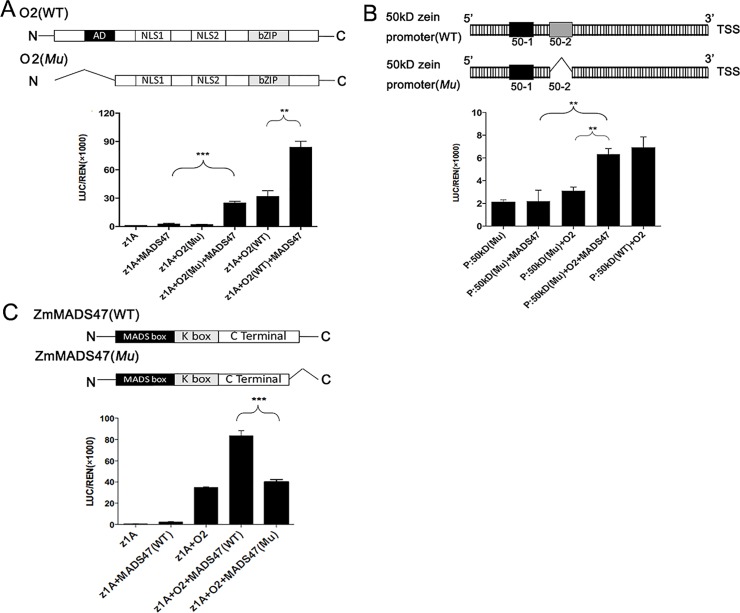
Transactivation ratio of O2 and ZmMADS47.A. Schematic representation of AD-truncated O2 construction. LUC/REN indicates the ratio of the firefly luciferase activity and the renilla reniformis activity. Error bars represent SD (n = 6) (*P < 0.05, **P < 0.01, ***P < 0.001, Student’s t test). B. Schematic representation of the 50–2 motif deletion in 50-kD γ-zein promoter. LUC/REN indicates the ratio of the firefly luciferase activity and the renilla reniformis activity. Error bars represent SD (n = 6) (*P < 0.05, **P < 0.01, ***P < 0.001, Student’s t test). C. Schematic representation of seven amino acid deletion at the C-terminus of ZmMADS47. LUC/REN indicate the ratio of the firefly luciferase activity and the renilla reniformis activity. Error bars represent SD (n = 6) (*P < 0.05, **P < 0.01, ***P < 0.001, Student’s t test).